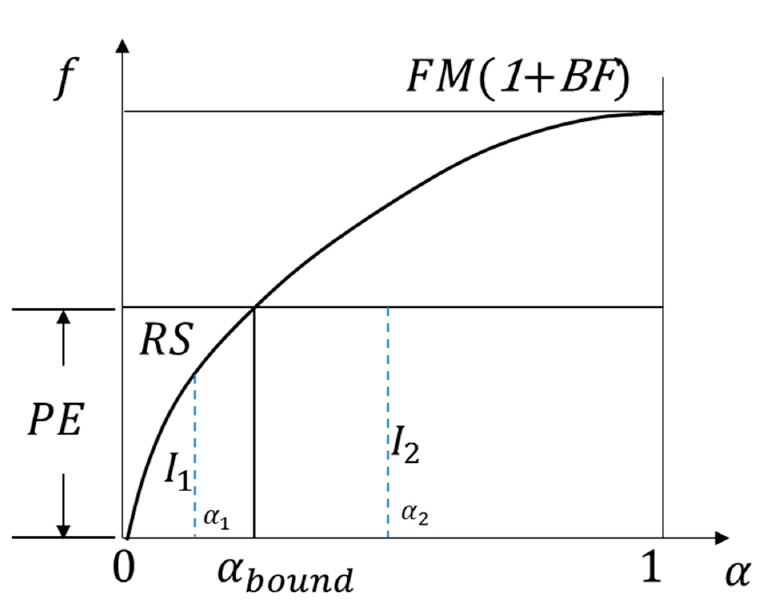
Figure 2. Distribution of infiltration capacity curve over the basin Note: PE = P − E , denotes precipitation excess. The denotations of the other symbols can be seen in text in Section 2.